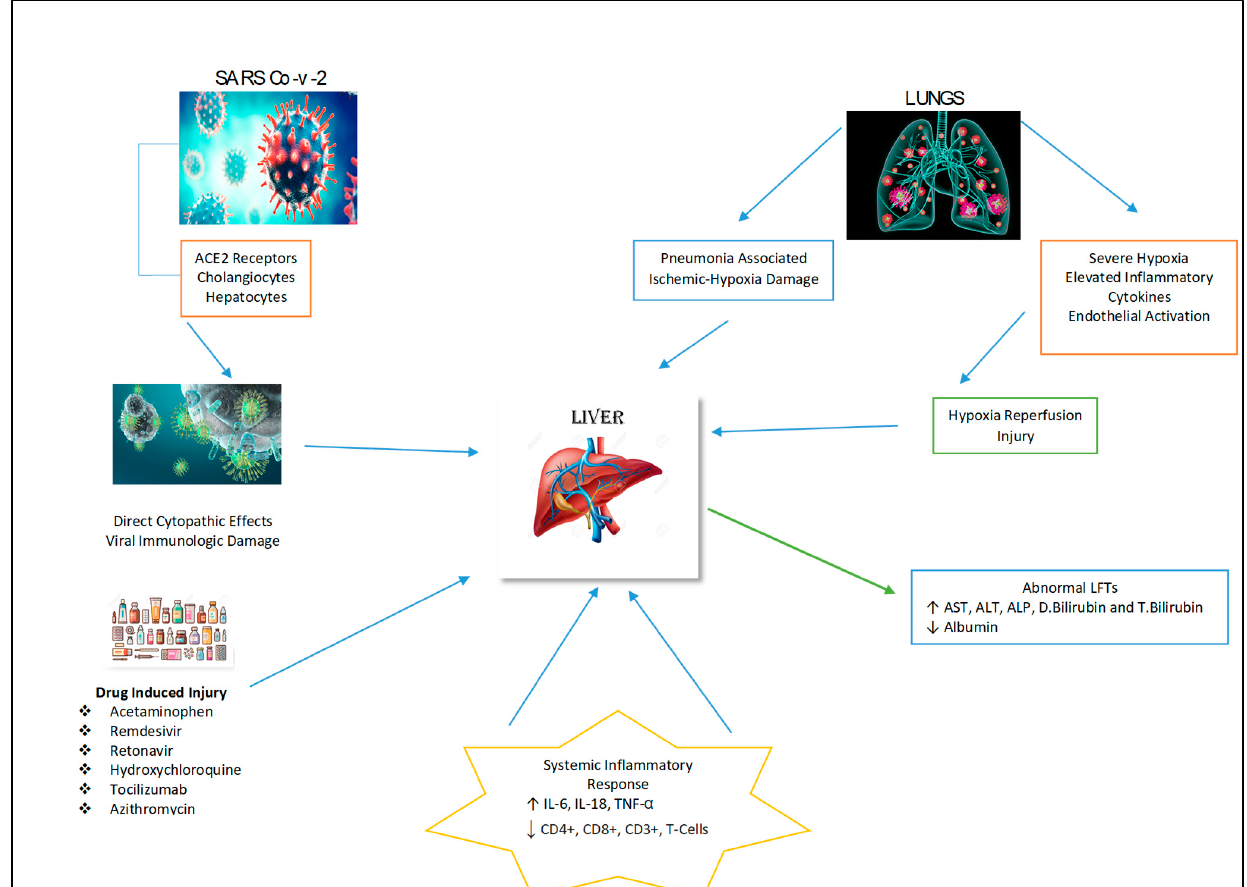
Figure 2. Possible mechanisms of hepatic injury in COVID ‐ 19 infection. In a report by Farcas et al. [23] on the autopsies of 19 patients who died of SARS ‐ CoV ‐ 2 infection, the virus was detected in 41% of liver tissue and the highest viral load was 1.6 × 10 6 copies/g of tissue. In an earlier study that examined biopsies from three COVID ‐ 19 patients with presentation of liver impairment, apoptosis was seen in all three patients and a noticeable buildup of cells in mitosis in two patients. In addition, patholog ‐ ical features observed included mild as well as moderate lymphocytic infiltration into the lobular regions with no fibrosis or eosinophilic infiltration [24]. Notably, histological in ‐ vestigation showed definitive low titer of SARS ‐ CoV ‐ 2 in the liver of the patients [24]. 4. Drug ‐ Induced Hepatic Injury in COVID ‐ 19 4.1. Lopinavir and Ritonavir There are a number of medications that have been used to manage COVID ‐ 19 pa ‐ tients and associated symptoms. These therapeutic agents include antivirals, acetamino ‐ phen, steroids, corticosteroids, immune ‐ modulators, antibiotics and antipyretics that are metabolized by the liver, and their use may cause hepatotoxicity (Figure 2) [25]. The liver injury induced by these medications have been reported to be the cause of abnormalities in liver biochemistry tests and histological changes such as hepatic inflammation and mi ‐ cro ‐ vesicular steatosis in COVID ‐ 19 patients [26].